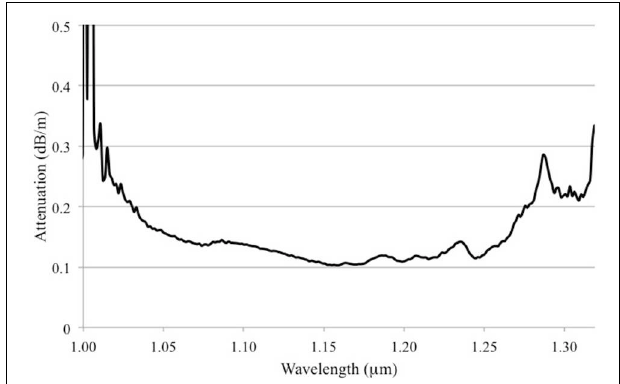
FIGURE 6 | Fiber output beam profile (2.94 µ m) for the NCF bent with a diameter of ∼ 50cm over a length of 80cm